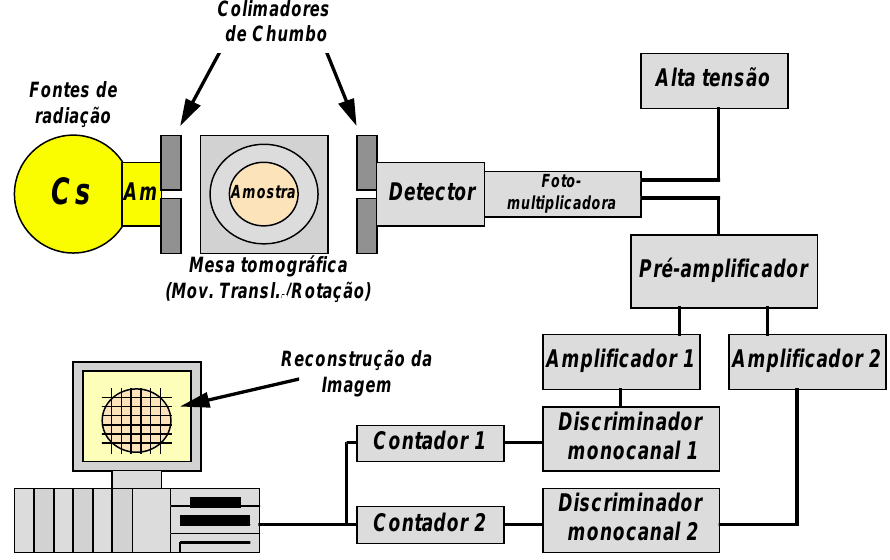
Figura 2. Representação esquemática do sistema tomográfico de dupla energia simultânea de radiação gama utilizado no